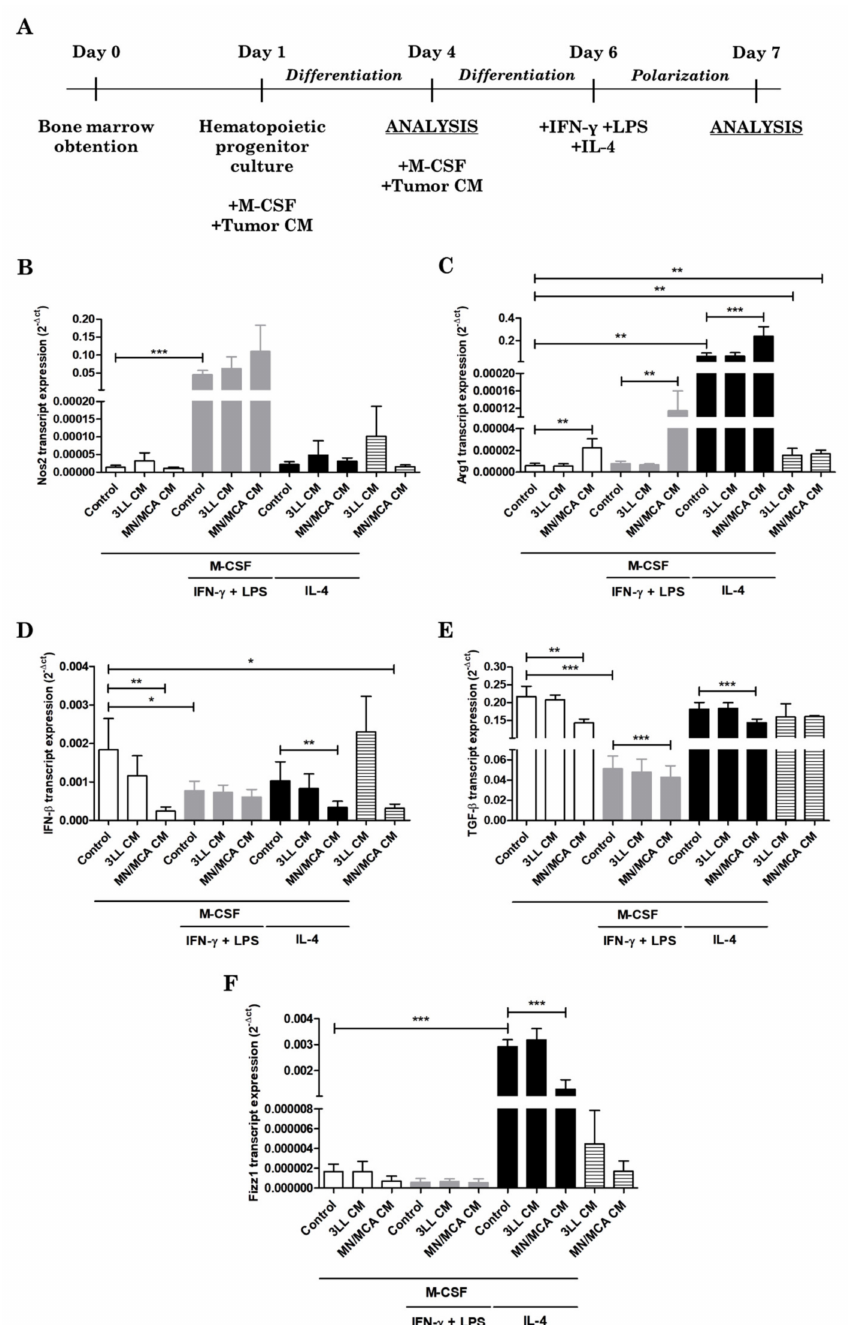
Figure 1. Tumor-conditioned media affect macrophage polarization. ( A ) Protocol of differentiation and polarization of macrophages with tumor products stimulation. ( B – F ) Bone marrow hematopoietic progenitor cells were collected and stimulated with M-CSF for 5 days in the presence of 3LL or MN/MCA-conditioned media (CM). After the initial differentiation with M-CSF, IFN- γ plus LPS or IL-4 were added to cultures for a further 24 h to induce polarization. Graphs show the abundance of transcripts encoding inducible nitric oxide synthase (Nos2; ( B )), arginase 1 (Arg1; ( C )), interferon- β (IFN- β ; ( D )), transforming growth factor- β (TGF- β ; ( E )), and found in inflammatory zone 1 (Fizz1; ( F )) in M0 (white bars), M1-like (grey bars), M2-like (black bars), and CM alone (striped bars)- stimulated cells. Results are shown as 2 − ∆ ct . n ≥ 4 independent experiments. *: p ≤ 0.05; **: p ≤ 0.01; ***: p ≤